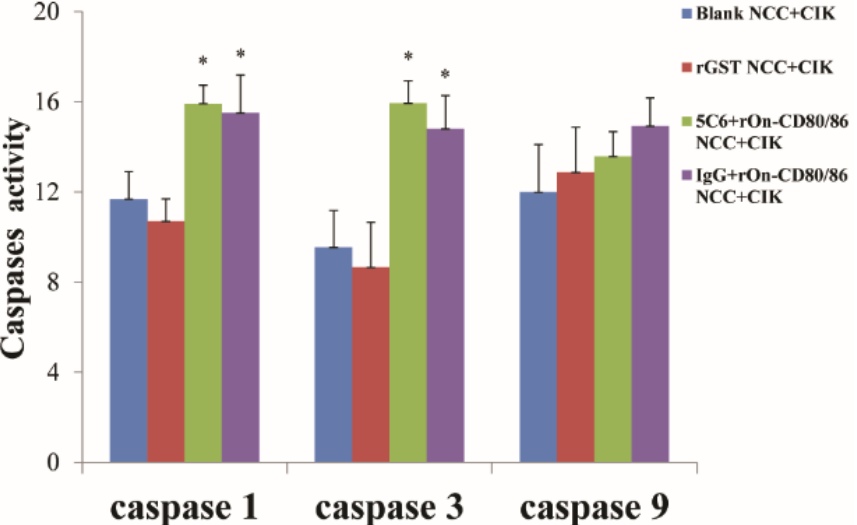
Figure 4. Effect of caspase-1, 3, and 9 activities in CIK by rOn-CD80/86-activated NCC. Value represents the mean ± S.E, n = 3. Significant difference was expressed by *: 0.05 > p > 0.01.